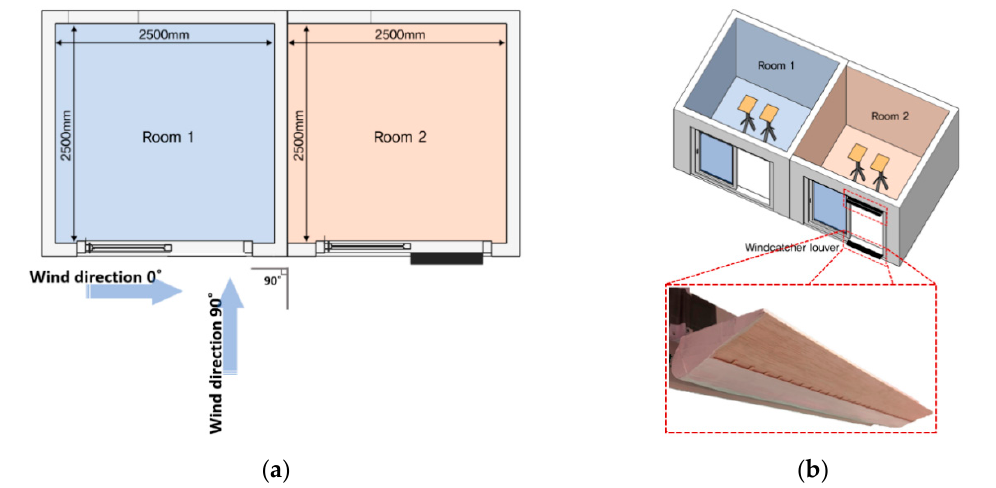
Table 6. Specifications of the measurement equipment used in the tests.